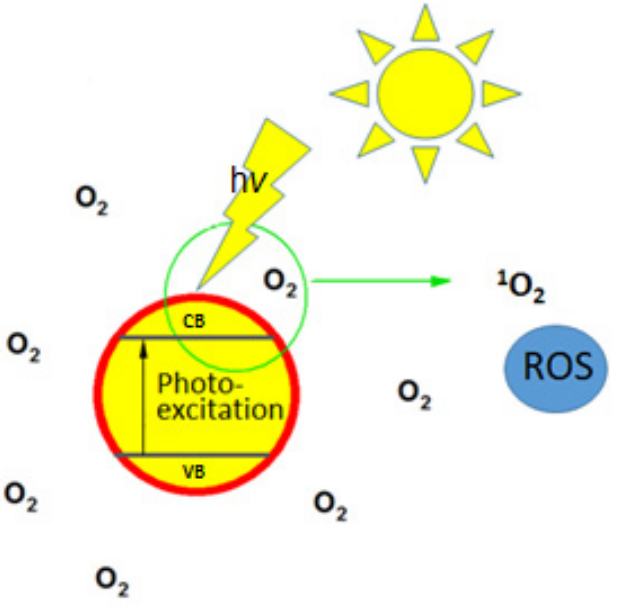
Figure 2. Schematic illustration of light-induced reactive oxygen species (ROS) generation: the creation of singlet oxygen ( 1 O 2 ) from atmospheric oxygen (O 2 ) on the surface of photoactive materials under (sun)light illumination.